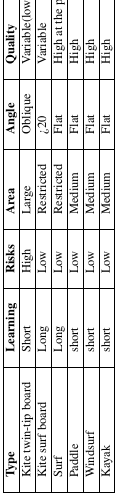
Table 1. Comparisons of platforms to collect data